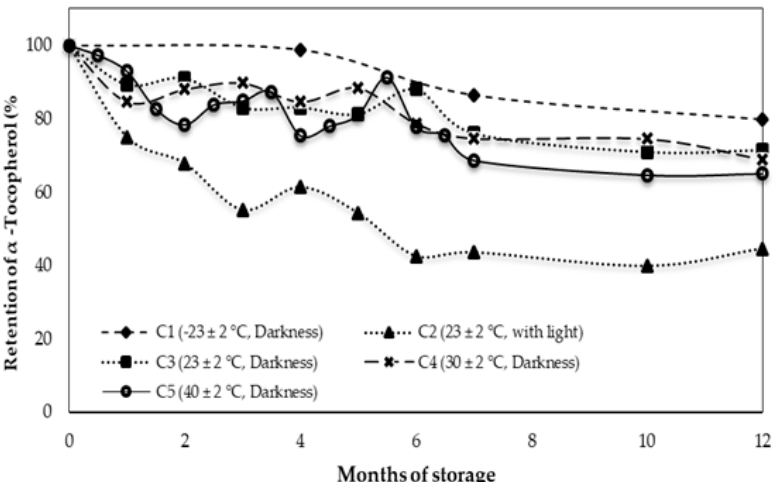
Figure 1. Evolution of α - tocopherol, during 12 months of storage for different storage conditions. Temperature also appears to strongly influence the degradation of α -tocopherol as storage at 40 °C (C5) resulted in significant degradation ( p < 0.05) relative to the initial level, despite being stored in darkness. Under this condition, α -tocopherol would inter- rupt the propagation step in lipid autoxidation based on the redox system of tocopherol- tocopheryl semiquinone [34,35]. The large loss of α -tocopherol in C2 can be attributed to the greater efficiency of photooxidation on lipid oxidation. 3.3. Behavior of Phenolic Compounds during Storage Table 2 shows the changes in levels of phenolic compounds following 12 months of storage. Arbequina variety EVOO had a total phenol content of 247 mg/kg of oil at the beginning of the storage period. This total phenol amount is in the expected range found for this variety and depends on other variables such as agroclimatic and processing factors [28]. As shown in Table 2, the simple phenols tyrosol and hydroxytyrosol, and elenolic acid increased during storage as a likely result of the hydrolytic degradation of the secoir- idoid compounds [36]. The largest increases were observed after 12 months of storage at room temperature with light (C2), and at higher temperatures in darkness (C4 and C5). The increase in tyrosol and hydroxytyrosol was not proportional to that of elenolic acid (molar ratio), possibly due to the active role of both phenols as antioxidants, which can trap free radicals formed under different storage conditions. Castillo-Luna et al. [9] pro- posed hydroxytyrosol as a reliable marker to detect aged EVOOs and blends prepared with aged EVOOs. Following 12 months of storage, no significant change was observed in the content of total phenols ( p > 0.05). Nevertheless, a significant increase in the content of total oxi- dized phenols was detected under conditions C2, C3, C4, and C5, reaching a value of 63 mg/kg in the latter, equivalent to 24% of the total phenols. The increase in oxidized phe- nols may be due to the oxidation of secoiridoid compounds, oleuropein, and ligustroside derivatives, predominant compounds present in fresh EVOO [37], which were oxidized at between 10 and 50% relative to their initial content. The decarboxymethylated compounds derived from oleuropein (oleacein) and ligustroside (oleocanthal) were the most oxidized (Table 2). This large degradation could be explained by the chemical structure and reactivity of secoiridoid derivatives. Oleacein and oleocanthal, with two aldehydic functional groups in an open configuration, possess